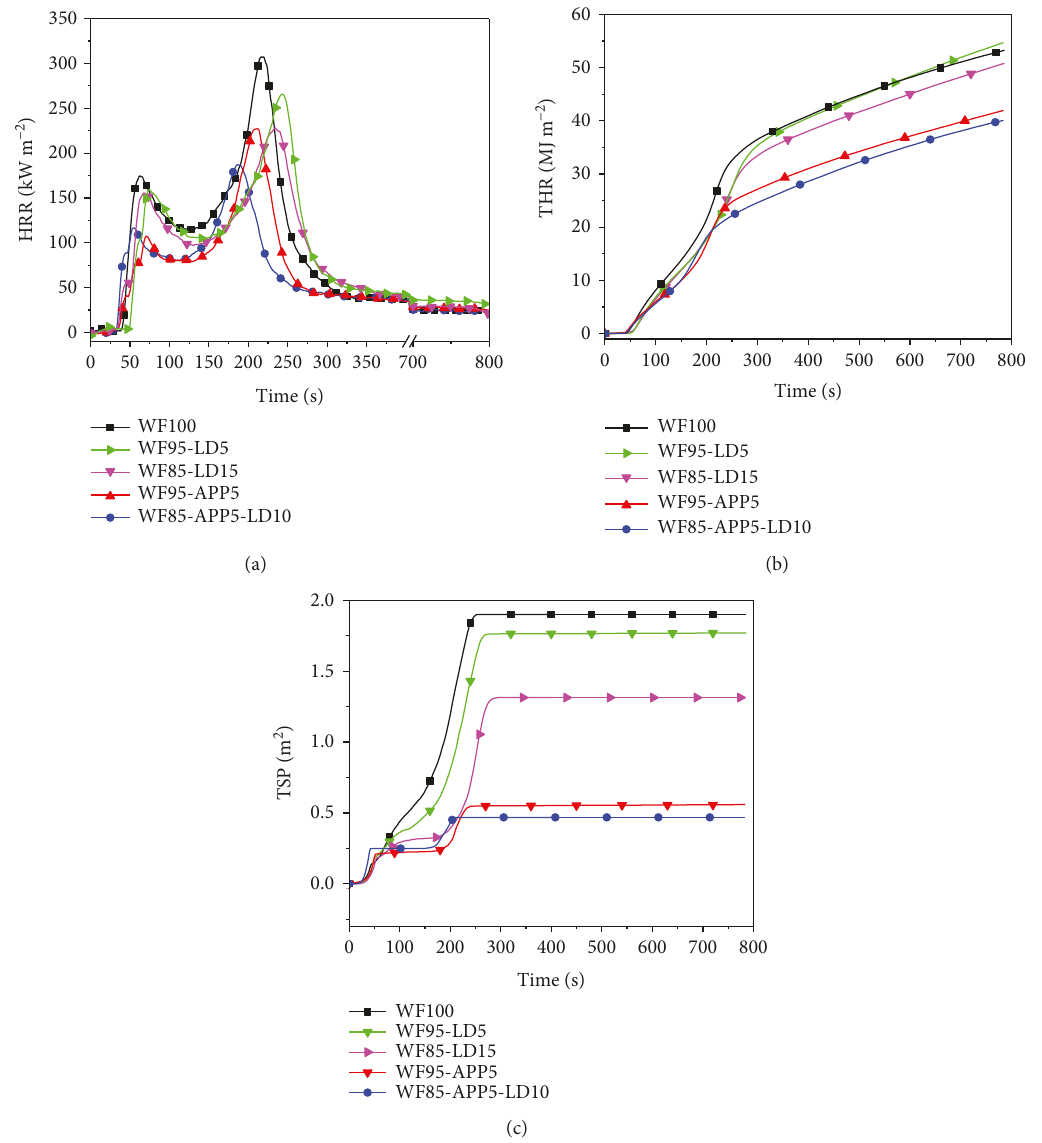
Figure 4: (a) HRR, (b) THR, and (c) TSP curves vs. combustion time of prepared